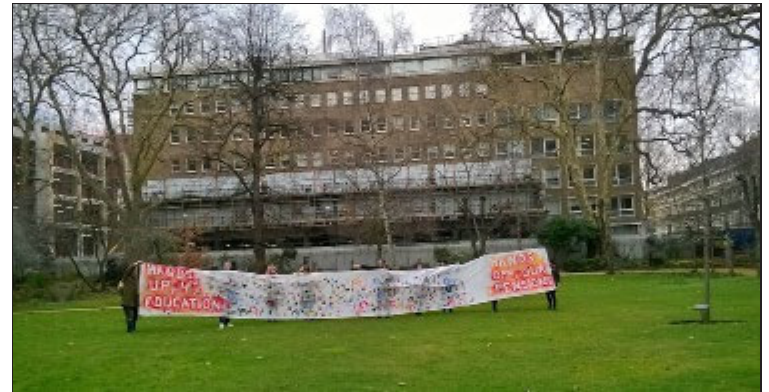
Figure 1: The ‘hands-up for education’ banner, inspired by Magdalenian cave paintings, 23rd February 2018 (Photo: Renata F. Peters).